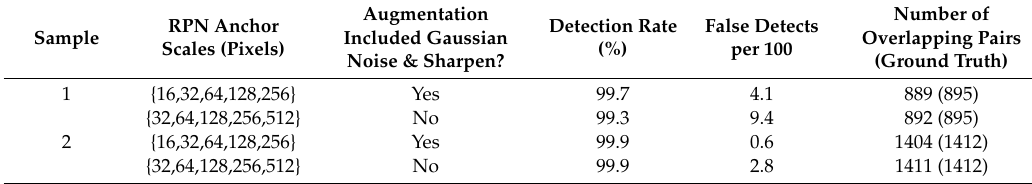
Table 2. Mask R-CNN results on mixed metal stained samples (test set